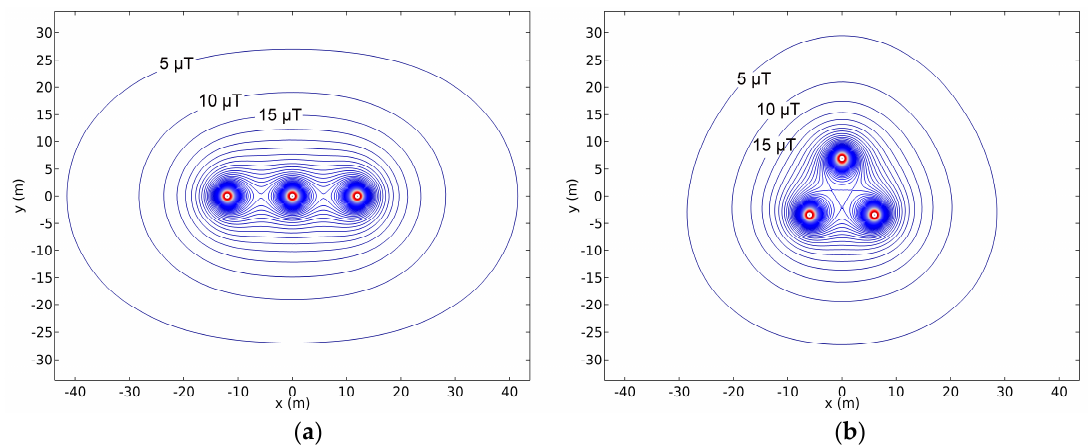
Figure 1. MF levels for a three-phase line in ( a ) flat configuration and in ( b ) triangular configuration (based on [13], CIGRÉ 2009).